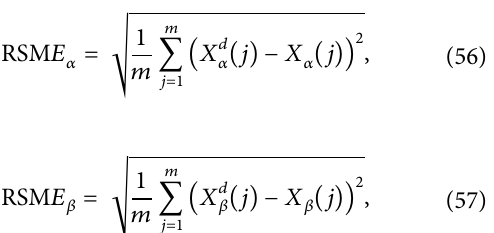
Table 2: Structural parameters of the parallel manipulator.